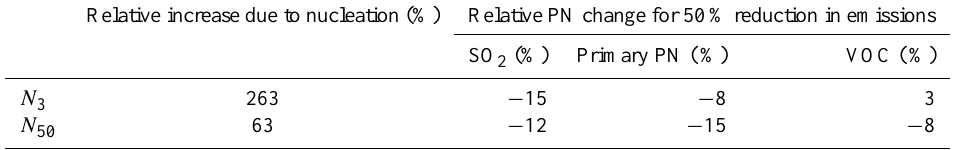
Table 2. Impact of nucleation and emission reductions on particle number concentrations in Europe. Where available, the values represent the average of PMCAMx-UF and GLOMAP. Otherwise the numbers are based on one of the models only. Relative increase due to nucleation (%) Relative PN change for 50% reduction in